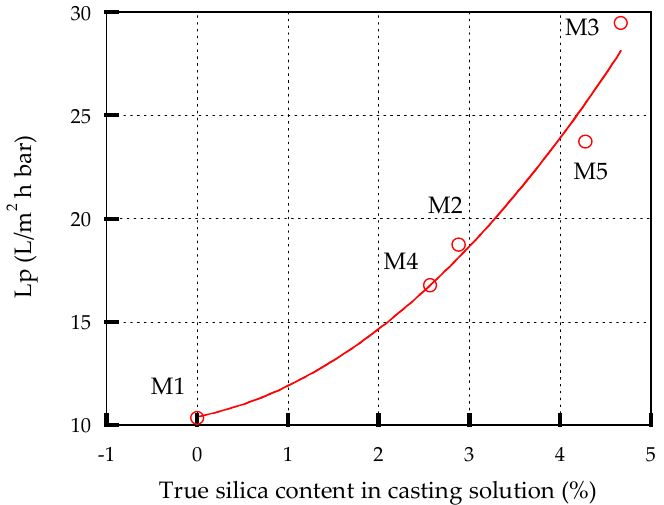
Figure 6. Lp as a function of true silica content in casting solution.